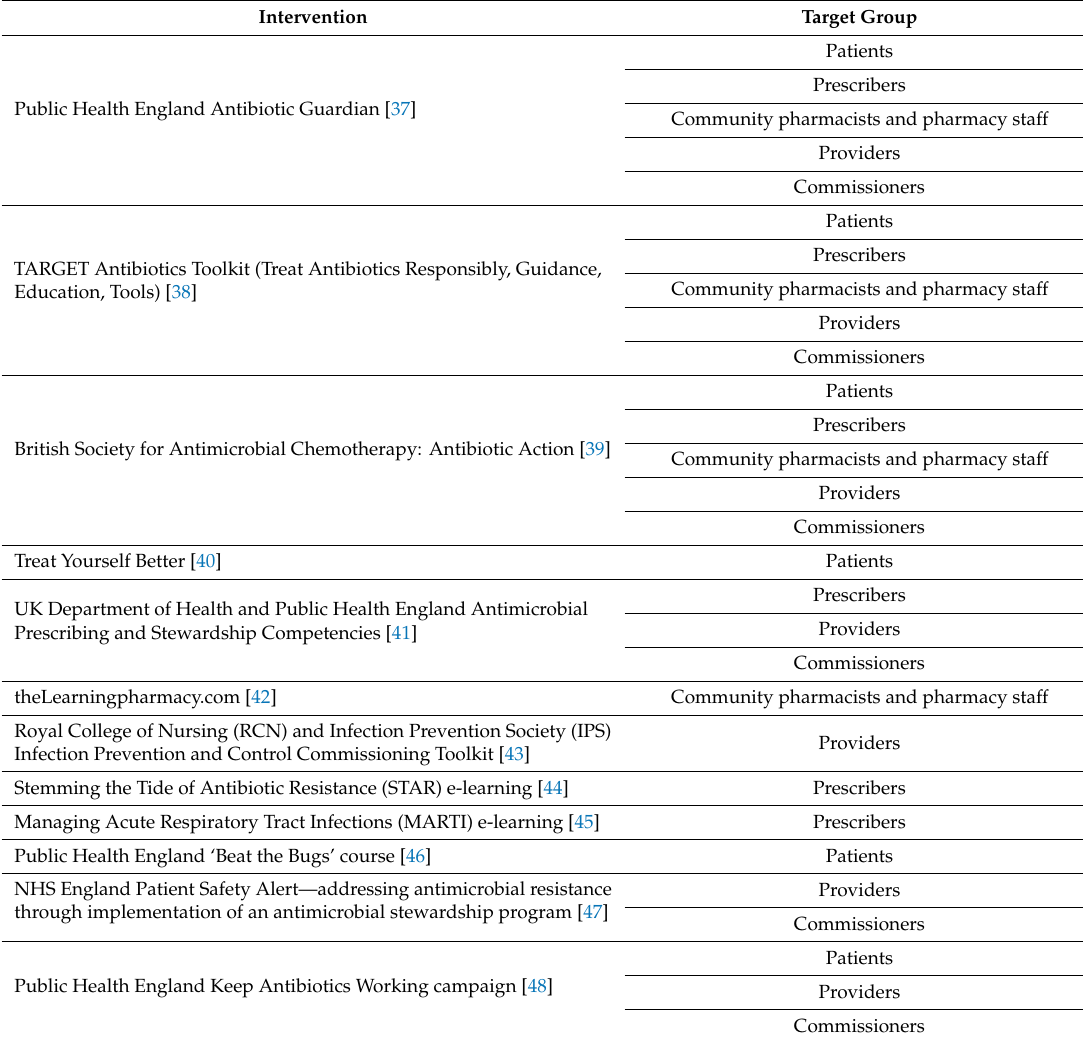
Table 2. Intervention and target